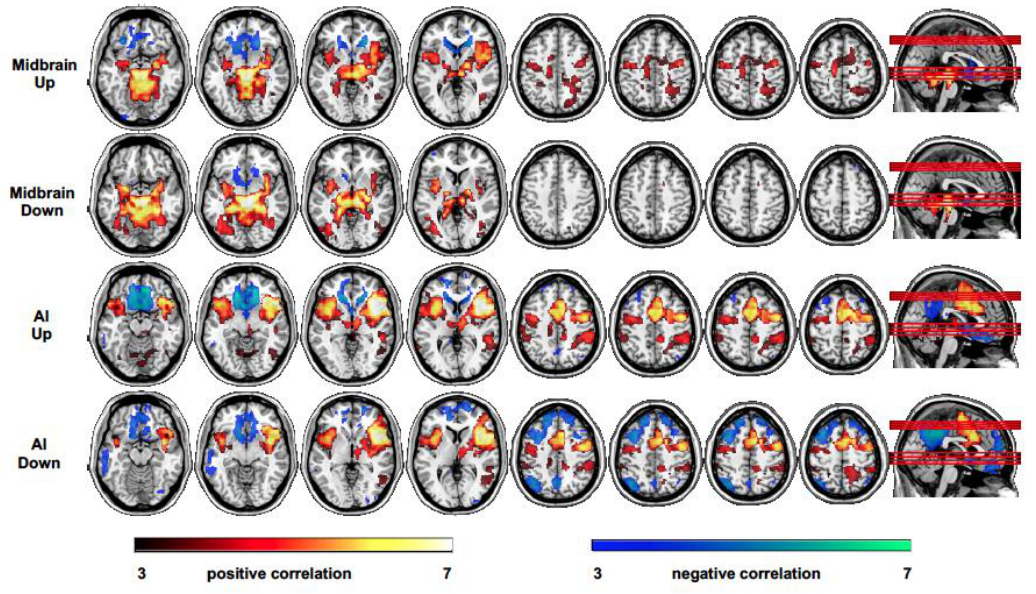
Figure 4. Patterns of functional connectivity measured as a positive and negative correlation of the midbrain with the whole brain (seed-to-voxel connectivity maps) during up and down emotion regulation, separately (first and second row); positive and negative correlation of the AI with the whole brain during up and down emotion regulation, separately (third and fourth row) .